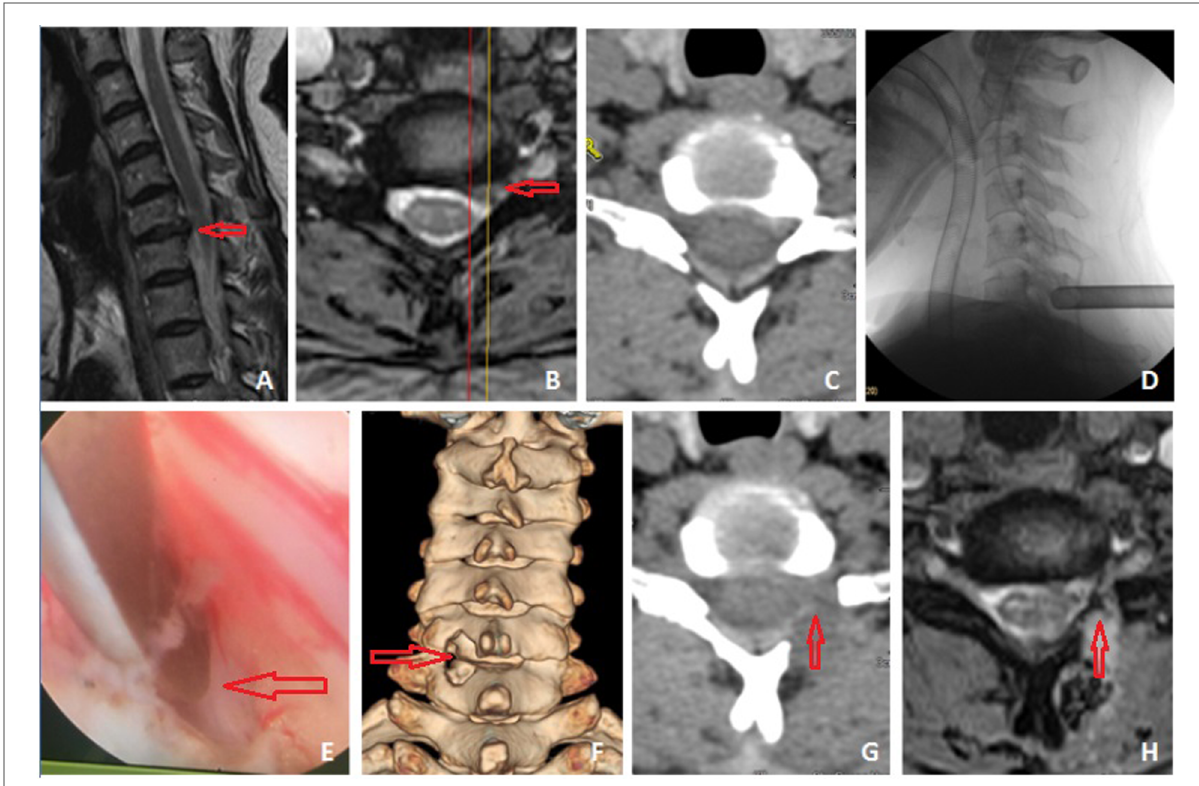
FIGURE 1 A patient with CSR (C6/7 left foraminal bony stenosis), female, 52 years old, was treated with posterior cervical full-endoscopic foraminotomy and decompression. Preoperative MRI and CT showed that C6/7 intervertebral disc protruded to the left rear, combined with left foraminal bony stenosis ( A – C ). After intraoperative localization, excising the herniated nucleus pulposus, cutting off the posterior osteophyte, performing foraminotomy and decompressing the nerve roots ( D,E ). Postoperative three-dimensional reconstruction CT showed a keyhole like decompression window in the